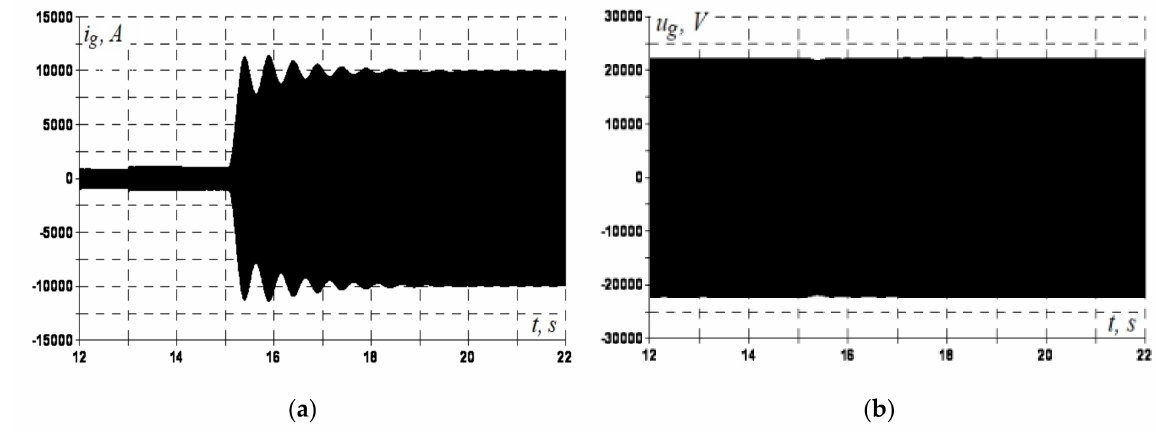
Figure 8. ( a ) Stator current ( i g , instantaneous value); ( b ) terminal voltage of the generator ( u g , instantaneous value) for connecting the generator to the power grid (at 13 s) and the active power loading (at 15 s).